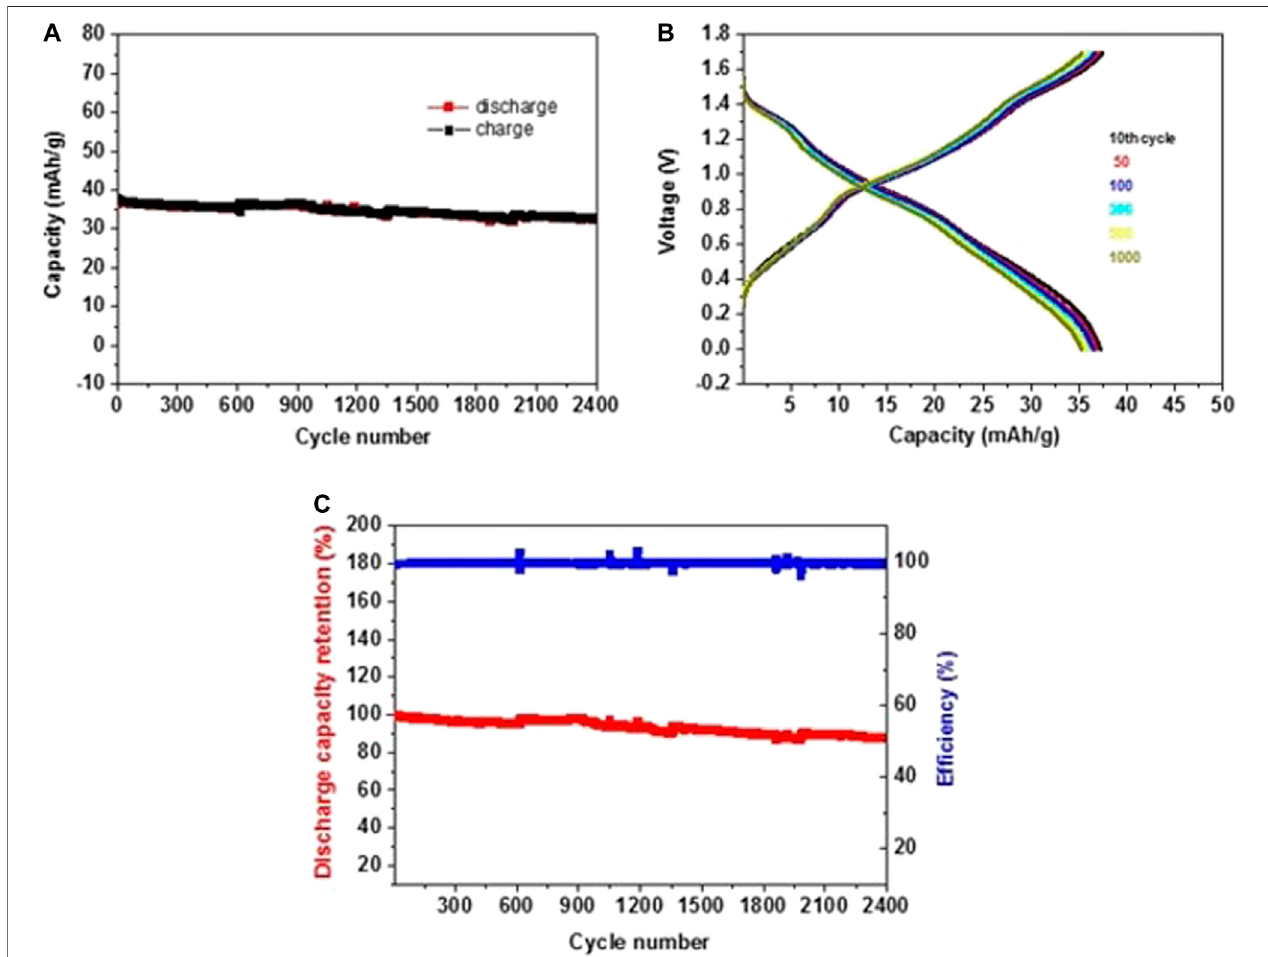
FIGURE 12 | (A) Galvanostatic charge – discharge capacity vs. cycle number at 5 C rate for NMO-PI/saturated NaClO 4 solution full cells operating in the range 0 – 1.7 V. (B) Charge – discharge pro fi les for different cycles. (C) Discharge capacity retention (red) and cycling ef fi ciency (blue) vs. cycle number.